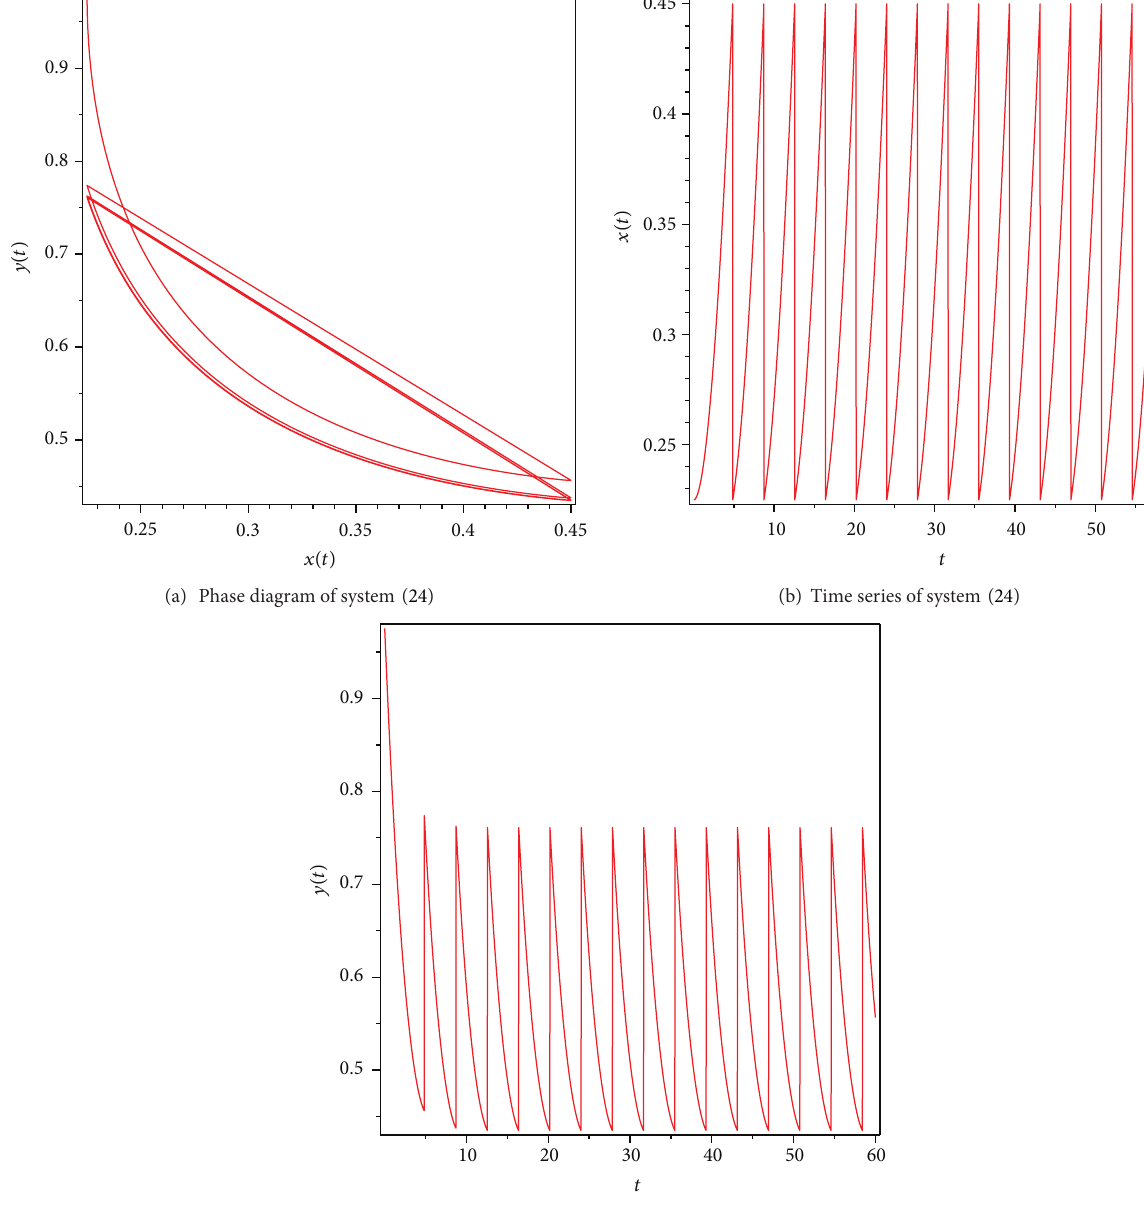
Figure 21: Illustration of basic behavior of system